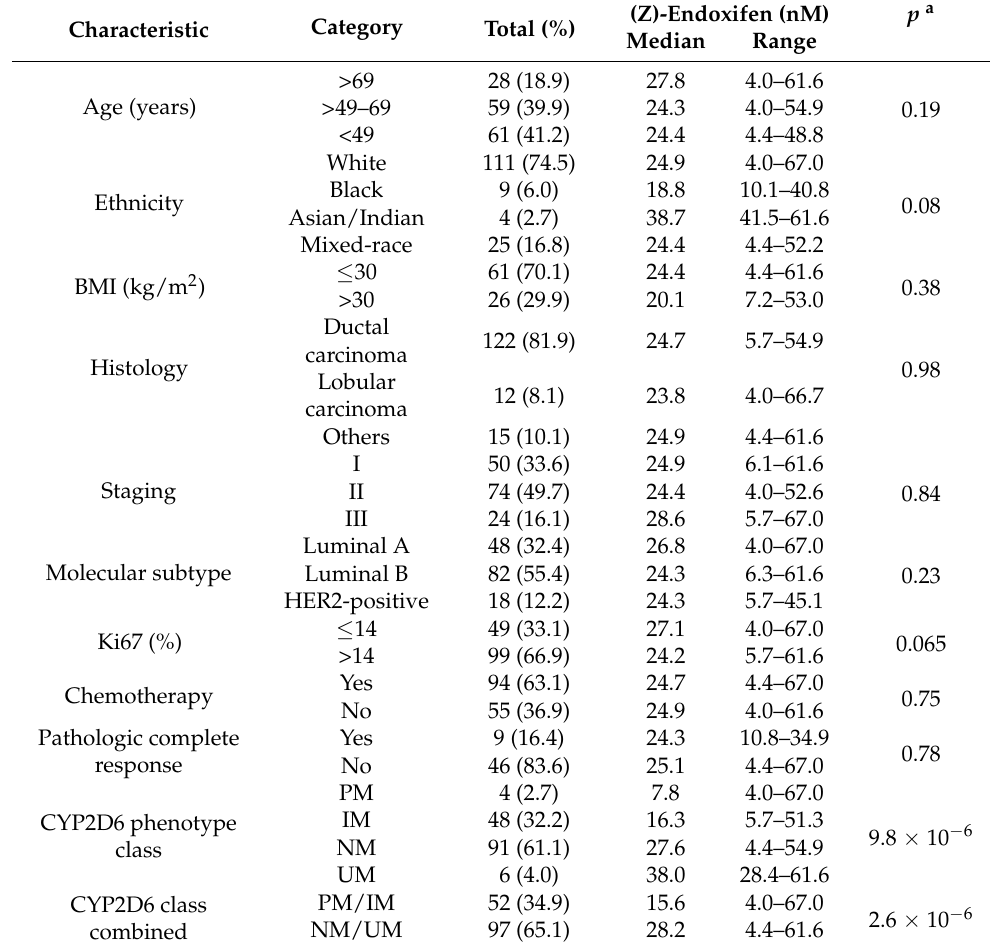
Table 1. Patient, pathological, and CYP2D6 phenotype characteristics and their relations to (Z)- Endoxifen